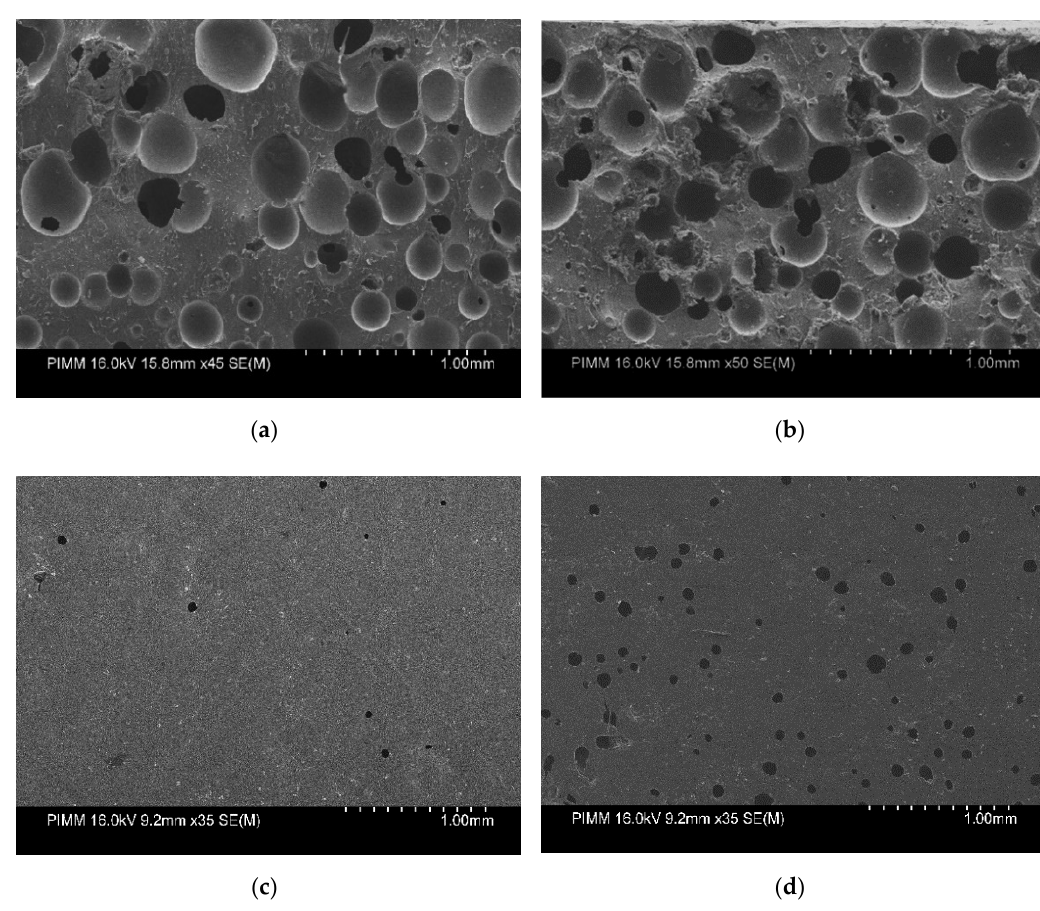
Figure 4. Micrographs of the ( a ) PU-10% DE and ( b ) PU-20% DE at Q7.5 after drug release of 96 h from the side and ( c ) PU-10%wt and ( d ) PU-20%wt from the surface side.